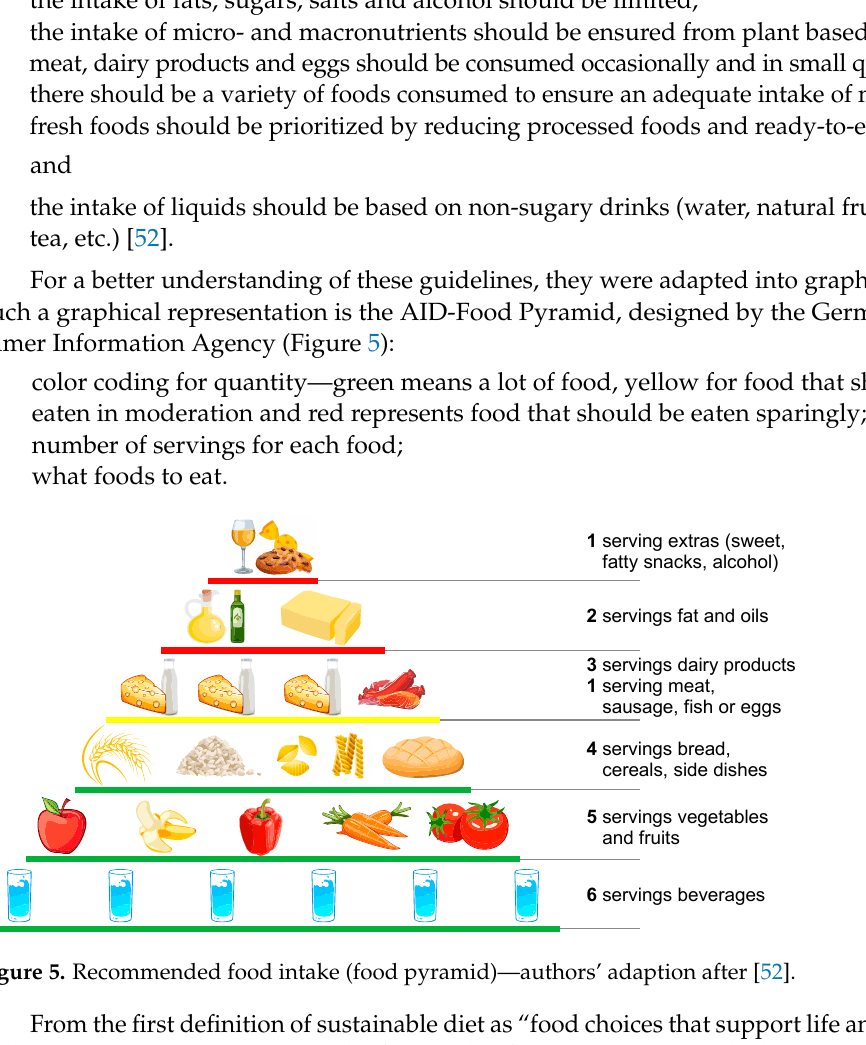
Figure 6. Key elements of a sustainable diet—authors’ adaptation of data from [53].